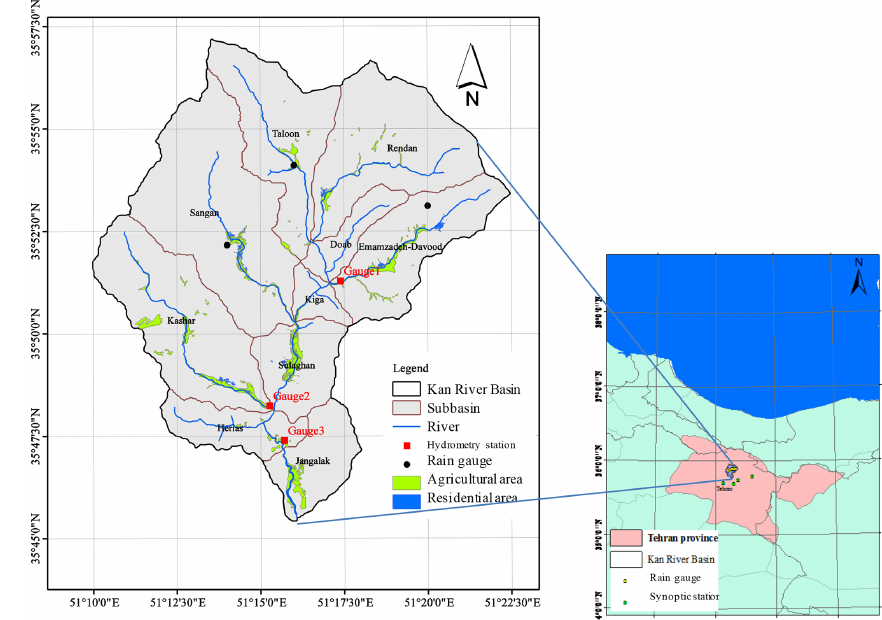
Figure 1. Location of the Kan River basin in the north of the Tehran plain, Iran.